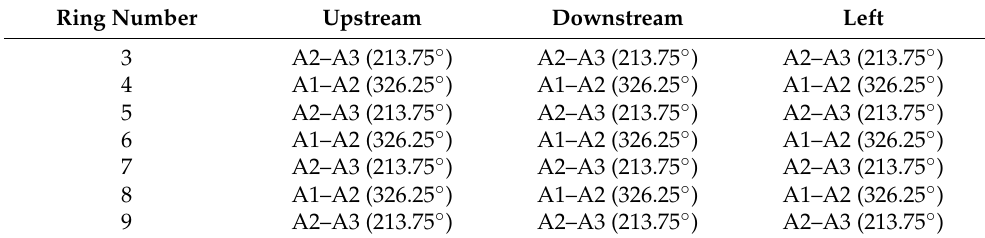
Table 4. Statistical table for the location of maximum segment